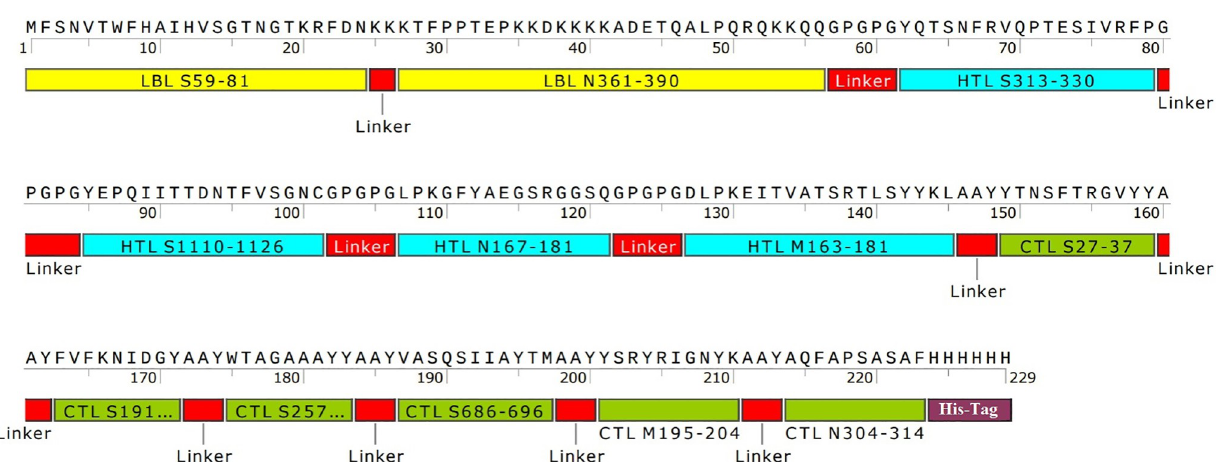
PLOS ONE | https://doi.org/10.1371/journal.pone.0268251 June 9,